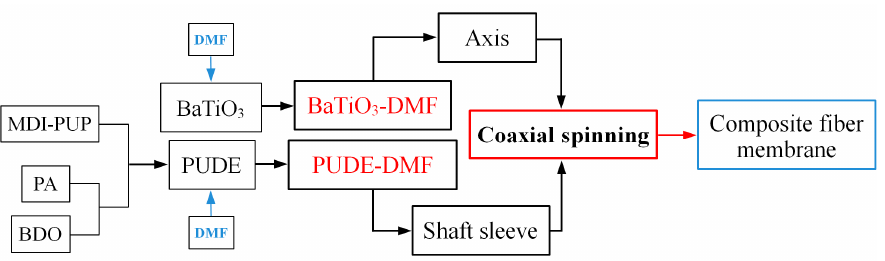
Figure 2. Flow chart for preparation of polyurethane composite fiber membrane.